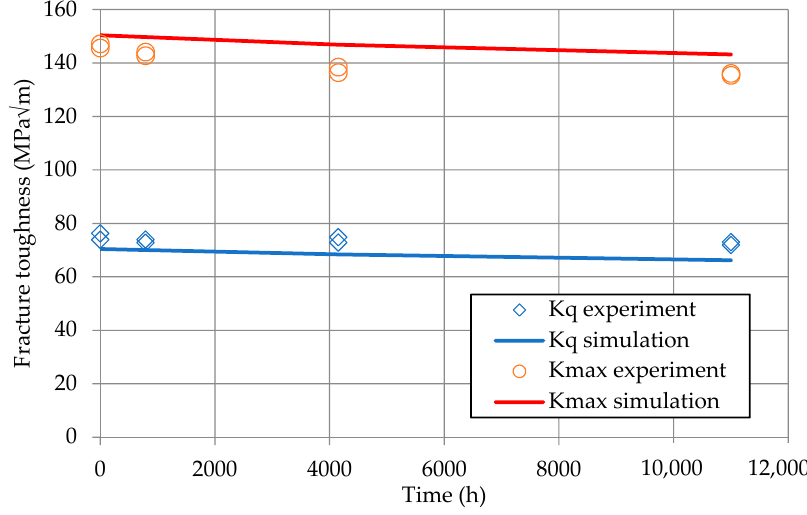
Figure 11. Numerically and experimentally determined fracture toughness values vs. ageing time of steel P91 at room temperature.